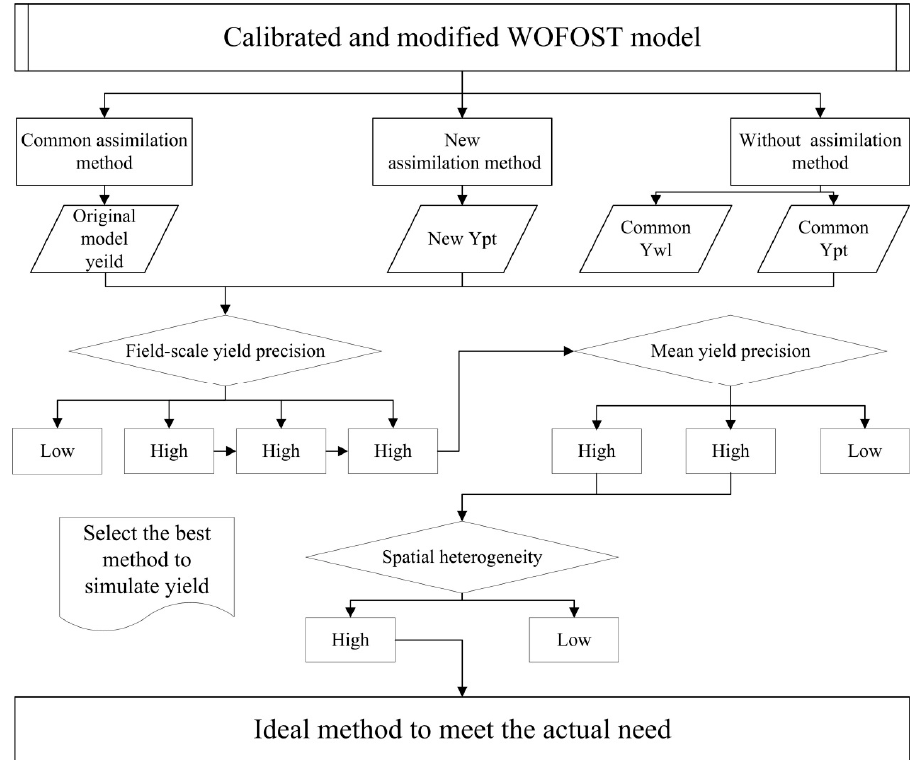
Figure 4. Process of selecting the new method.